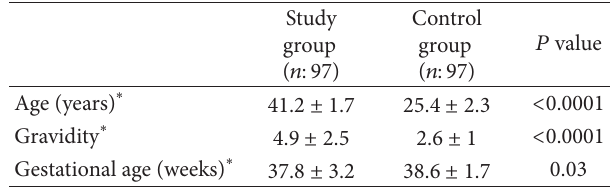
T 1: Patients characteristics.